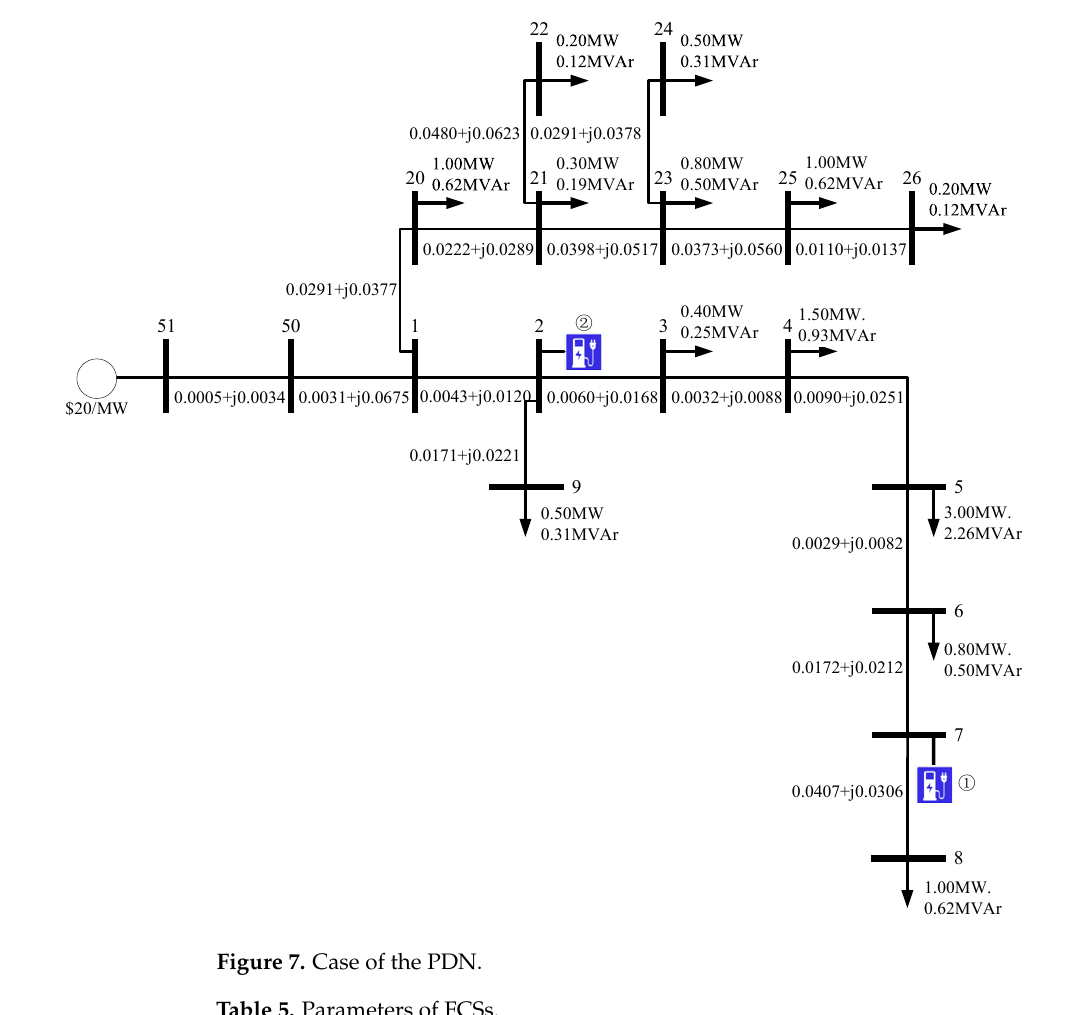
Figure 7. Case of the PDN. Table 5. Parameters of